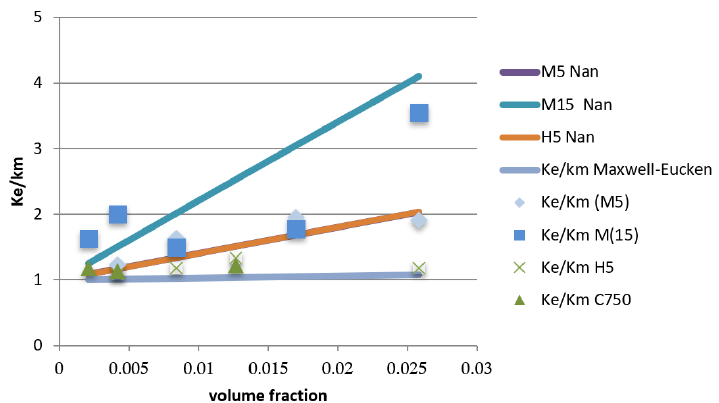
Figure 4. Ratio of thermal conductivity of composite paraffin wax with graphite nanoplatelets to the thermal conductivity of paraffin as a function of volume fraction with different sizes, aspect ratios, and surface areas: squares, M15 (diameter = 15 µ m, thickness = 6–8 nm, and surface area = 120–150 m 2 /g; diamonds, M5 (diameter = 5 µ m, thickness = 6–8 nm, and surface area = 120–150 m 2 /g; crosses, H5 (diameter = 5 µ m, thickness = 15 nm, and surface area = 50–80 m 2 /g); triangles, C750 (diameter < 2 µ m, thickness = a few nm, and surface area = 750 m 2 /g). The straight grey line represents the theoretical prediction of the Maxwell–Eucken model, and the blue and yellow lines represent Nan’s EMT model [27] for the dimensions of M15 and H5, respectively, with Rk = 9 × 10–8 m 2 K/W